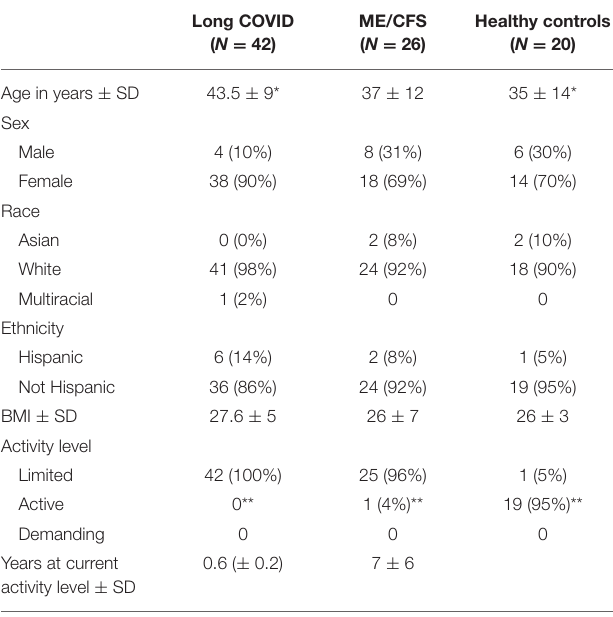
TABLE 1 | Study participant